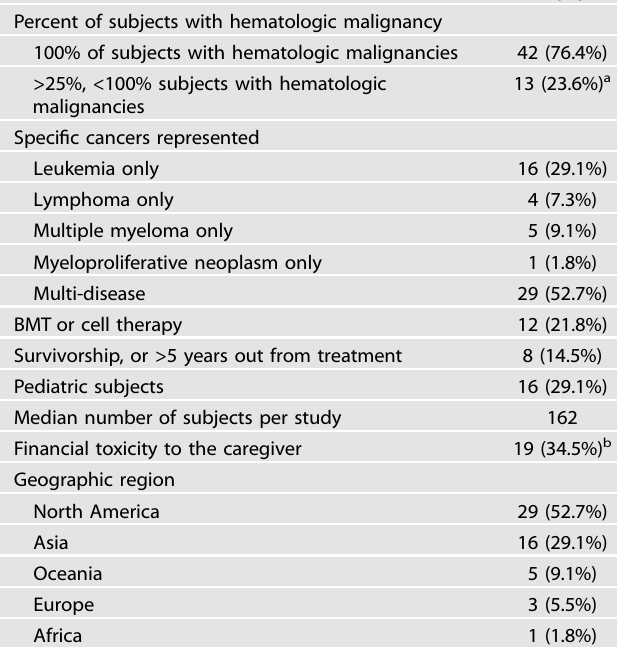
Table 1. Characteristics of patients in included studies.